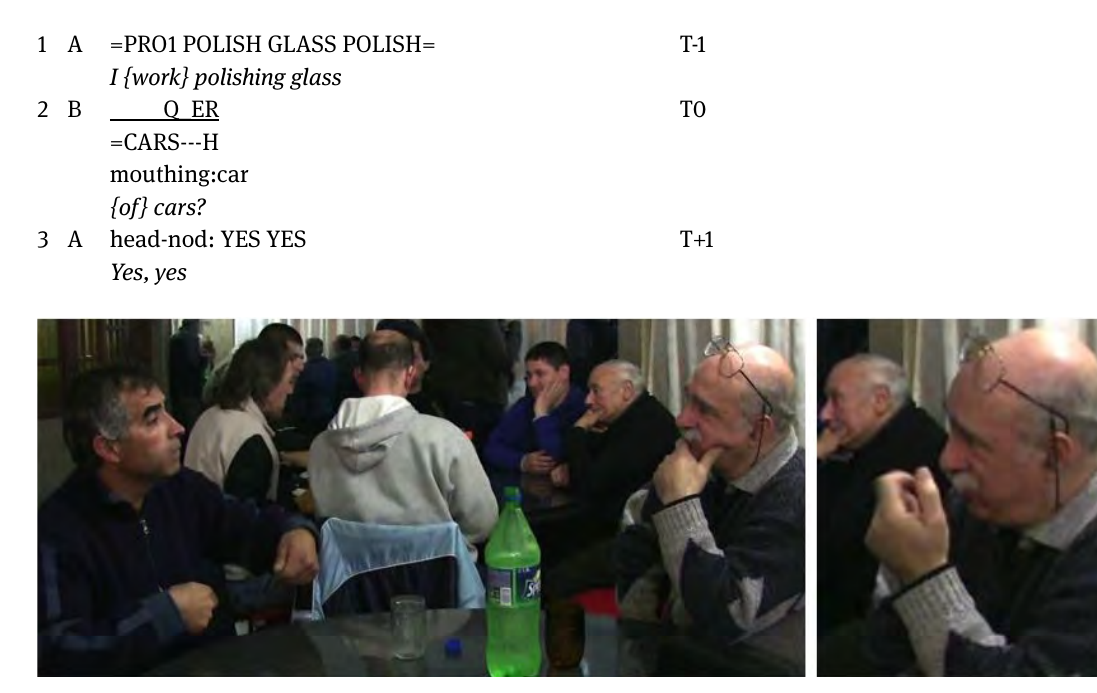
Figure 2: Stills of line 1 (L) and line 2 (R). In line 2, B initiates repair by offering a candidate understanding: ‘{of} cars?’. His raised eyebrows indicate a polar